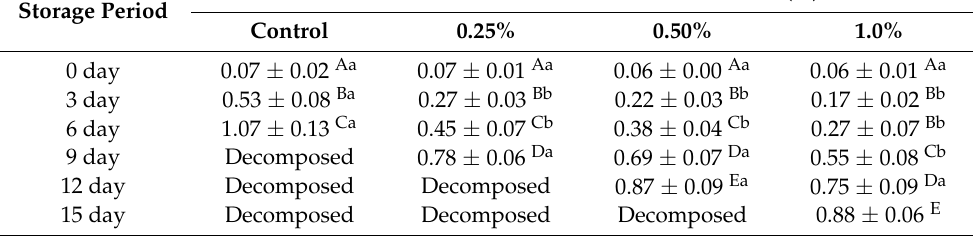
Means carrying a different capital or small superscript are significantly different ( p < 0.05) in the same column and row, respectively. Table 5. The pattern of peroxide value (PV) (mEq/kg) of the minced beef treated with ethanolic Cassia glauca leaf extracts (0.25%, 0.5%, 1%) during the cold storage period at 3 ± 1 ◦ C (mean ± standard deviation “SD”).